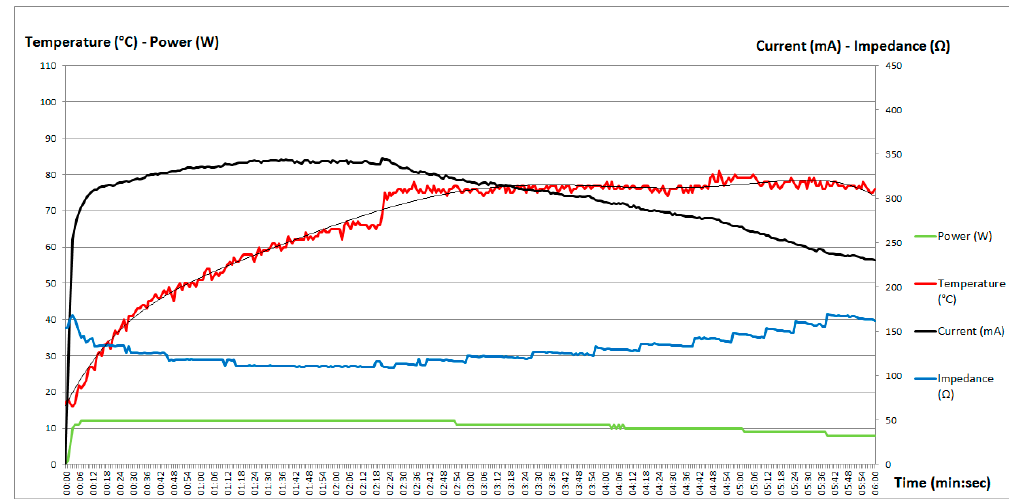
Figure 3. Ablation parameters analysis (impedance, temperature, current, power, time) at 10 W. X -axis represents ablation time, Y -axis temperature, power, current, and impedance applied by the system. Temperature ( Y -axis on the left side of the graph) was always maintained below the safety value of 100 °C during the ablation, avoiding the tissue charring and therefore allowing an “effective” ablation treatment.